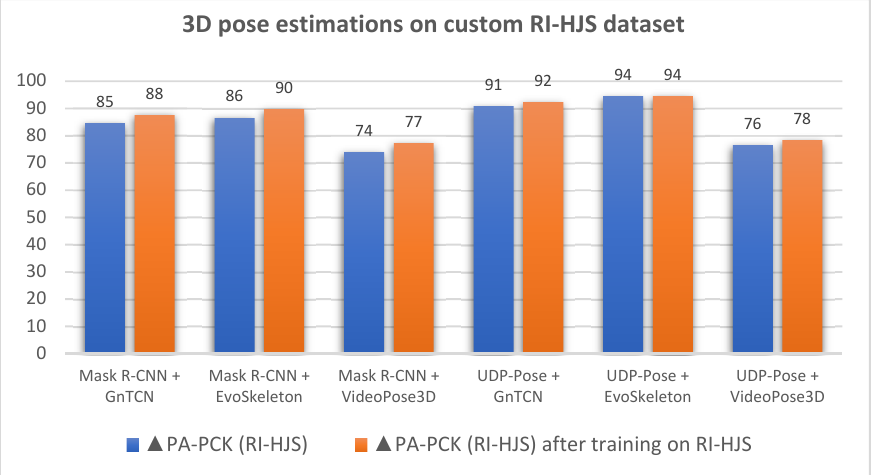
Figure 20. Comparison of pose sequence estimation in terms of PA-PCK on custom RI-HJS datasets before and after additional training of the Mask R-CNN and UDP-Pose models on training part on RI-HJS dataset (higher score is better).